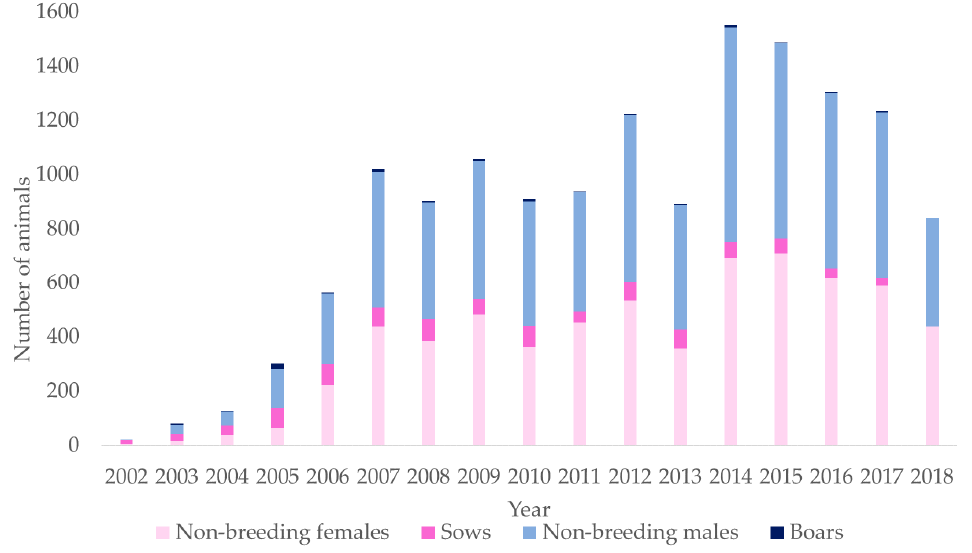
Figure 2. Animals registered per year of birth divided by sex and with or without progeny: Boars, non-breeding males, sows, and non-breeding females.